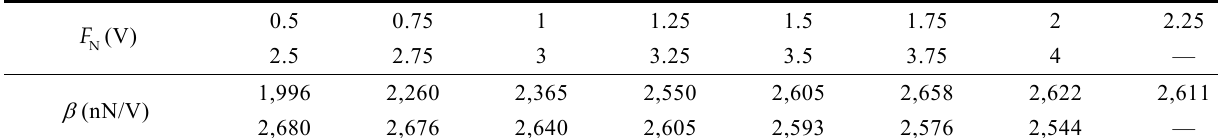
Fig. 6 Friction detected by scanning on the HOPG surface as a function of vibrational amplitudes for (a) x - and (b) y -directional vibration. Table 2 Calibration values for lateral sensitivity coefficient corresponding to various